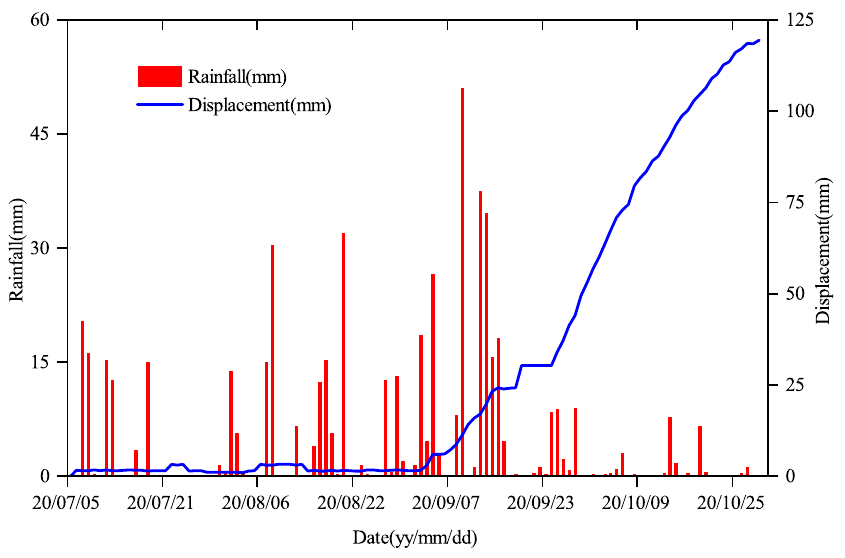
Figure 4. Comprehensive analysis curve of rainfall and